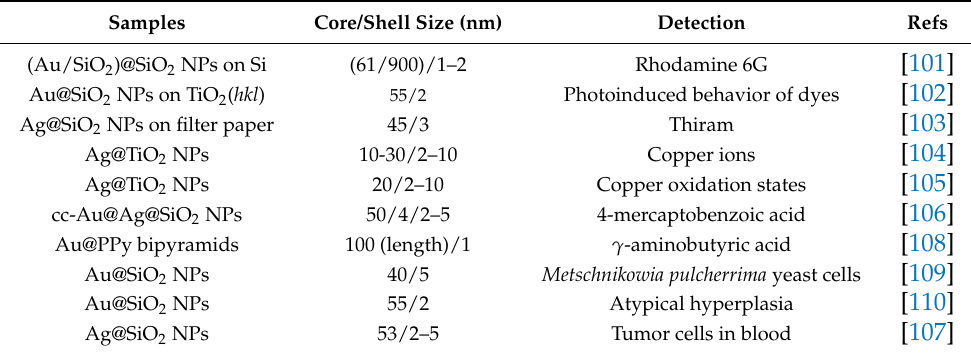
Table 3. SHINERS application for the detection of molecules and ions (NPs = nanoparticles; cc-Au = concave cubic gold; PPy =